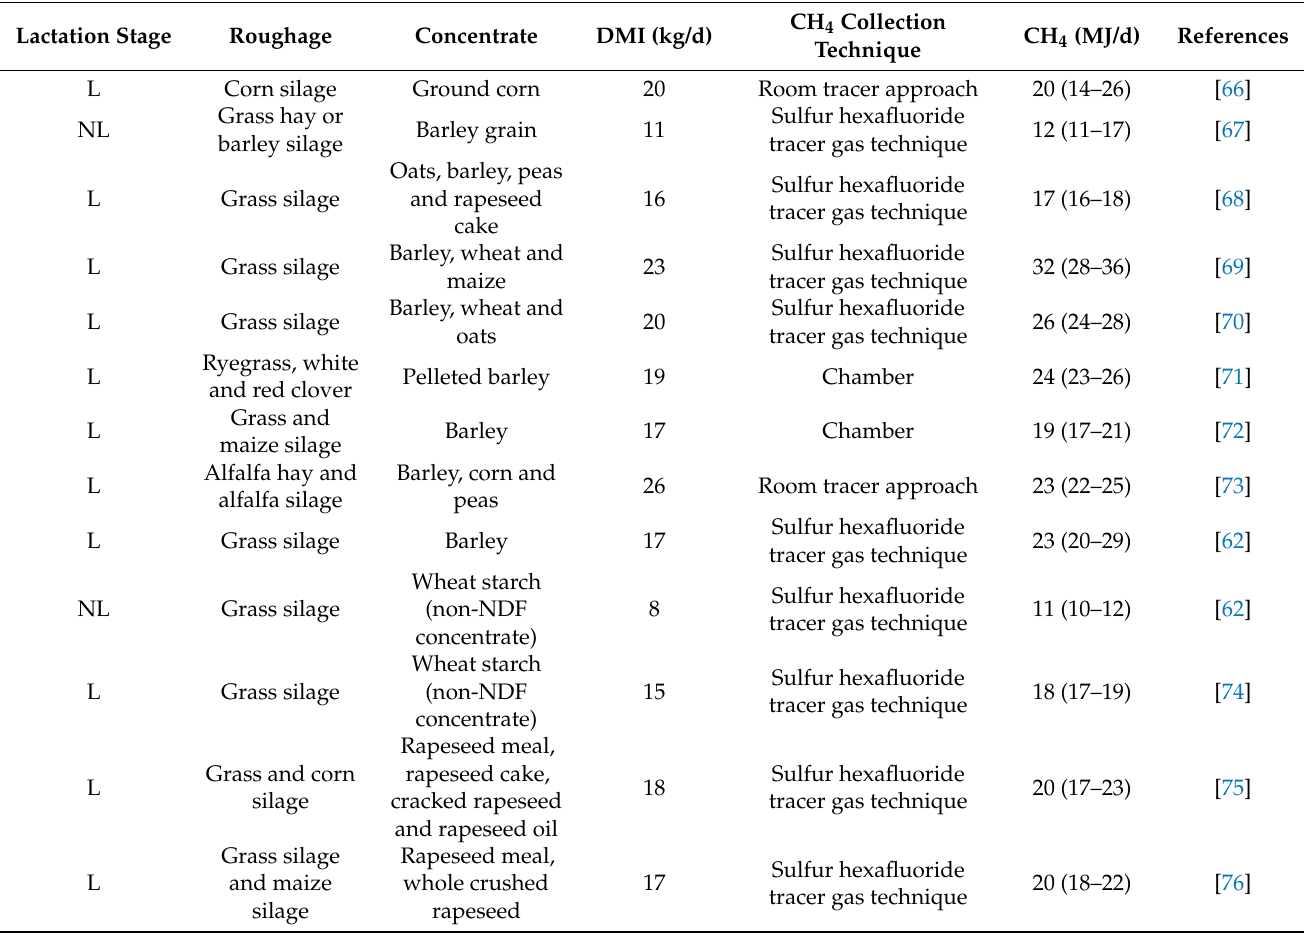
Figure 2. CH 4 emission MJ/d compared with DMI [62,63]. Table 2. Methane prediction models